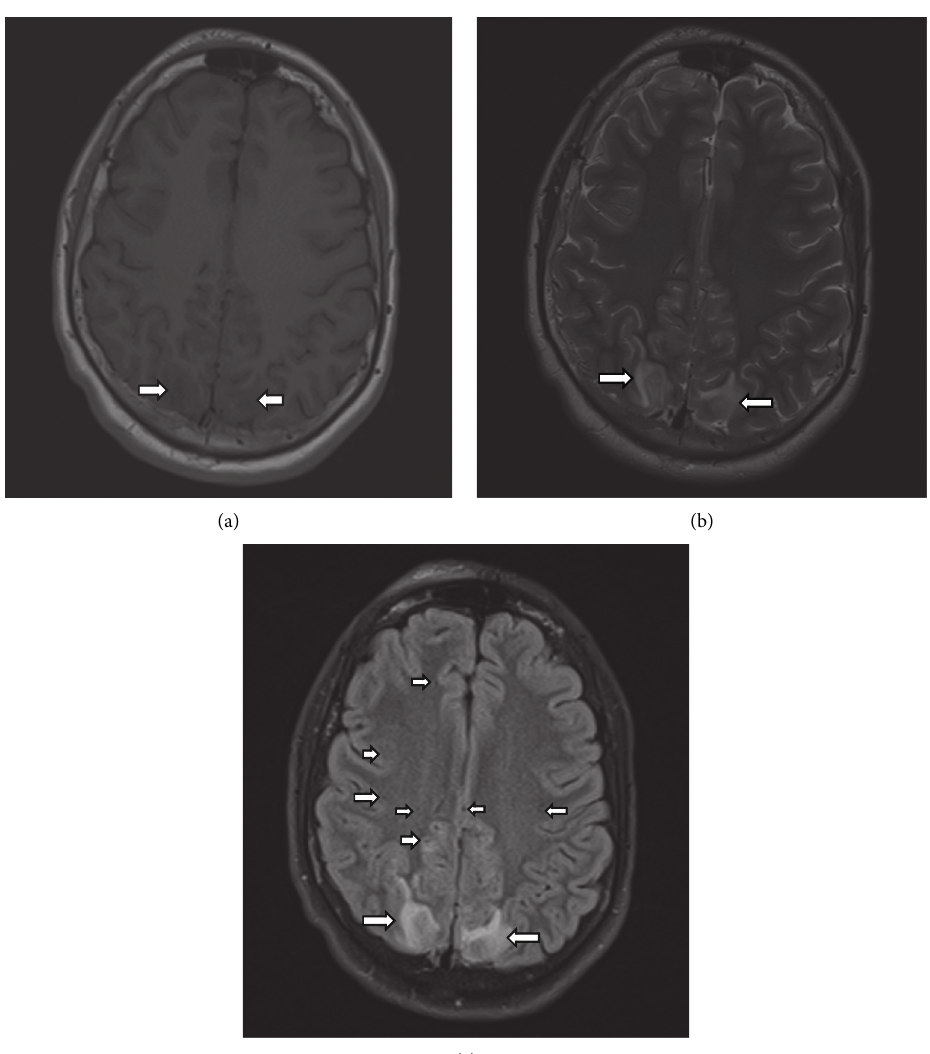
Figure 2: Axial T1-weighted (a), axial T2-weighted (b), and axial FLAIR (c) MRI images revealing increased signal consistent with edema in the cortex and subcortical white matter of the posterior parietal, temporal, and occipital lobes bilaterally. There are minimal scattered foci of hemorrhage in the anterior right anterior parietal